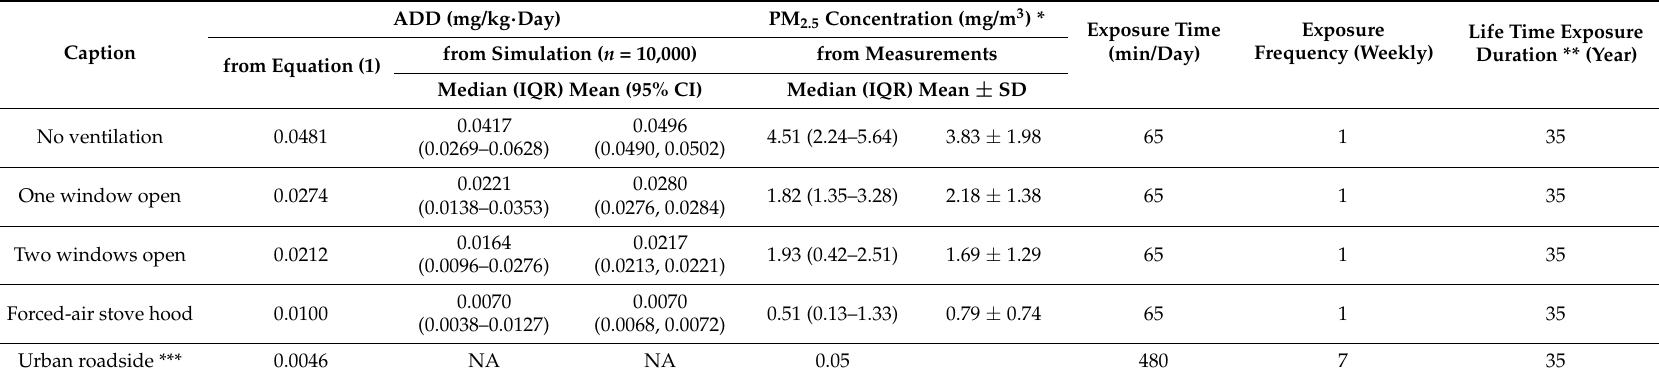
Table 2. Distributions of average daily doses (ADDs) from Monte-Carlo simulation using the distribution of indoor PM 2.5 levels observed under different ventilation conditions, as well as outdoor PM 2.5 levels obtained from urban roadsides.